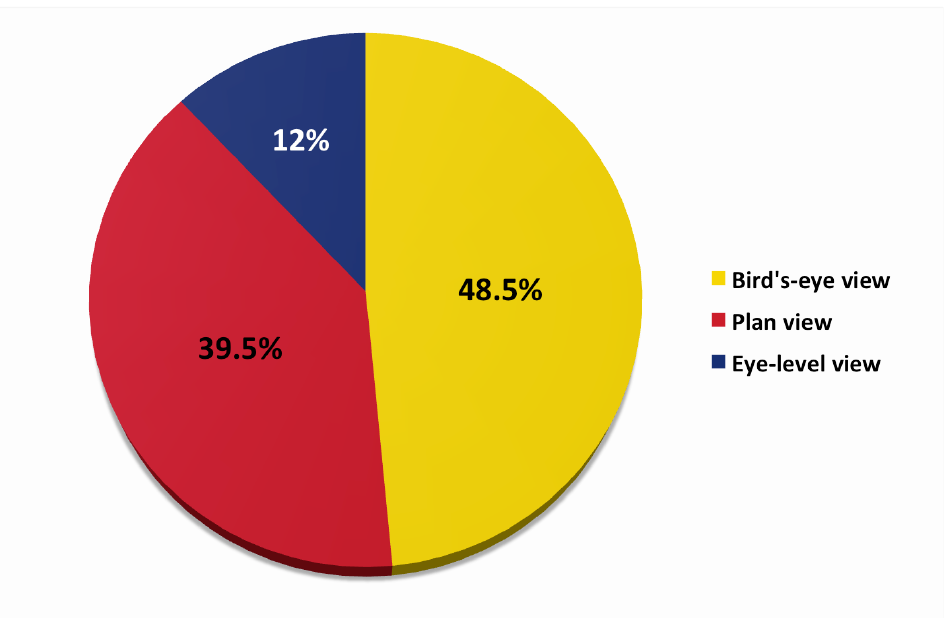
Figure 5. Comparison of the view utilization for the DT